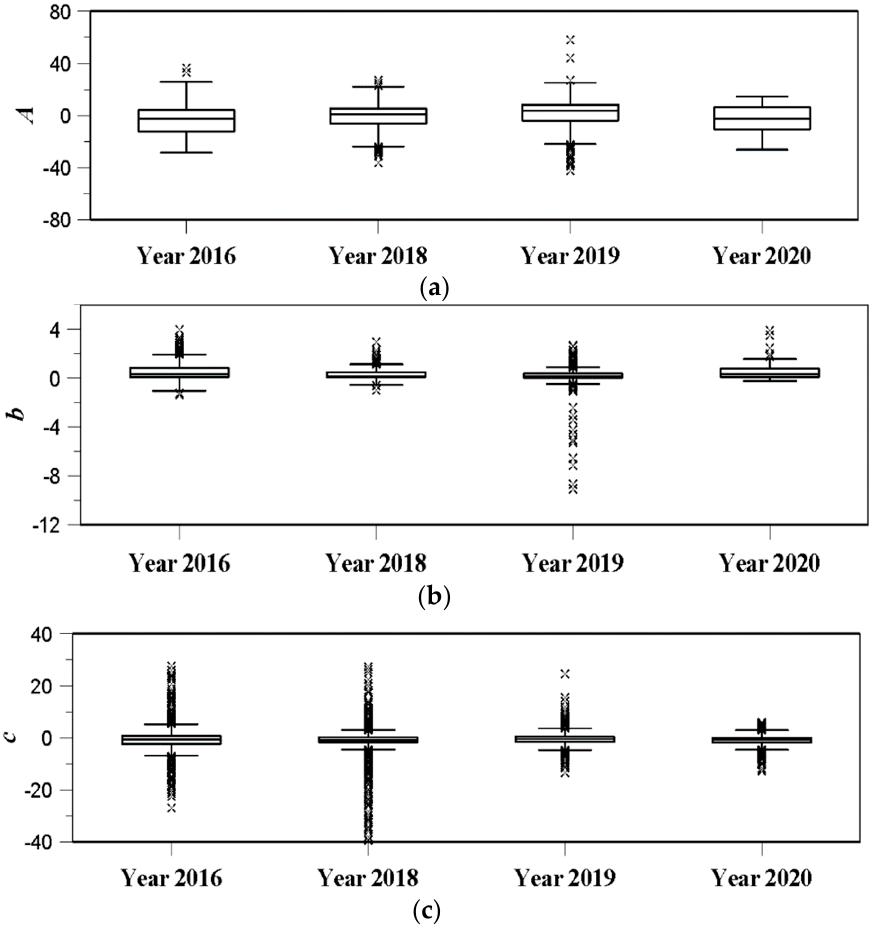
Figure 10. Comparison of box plots for three estimated parameters at 10 rain gauge stations for four storm events by applying the extended Kalman filter: ( a ) parameter A , ( b ) parameter b , ( c ) parameter c.